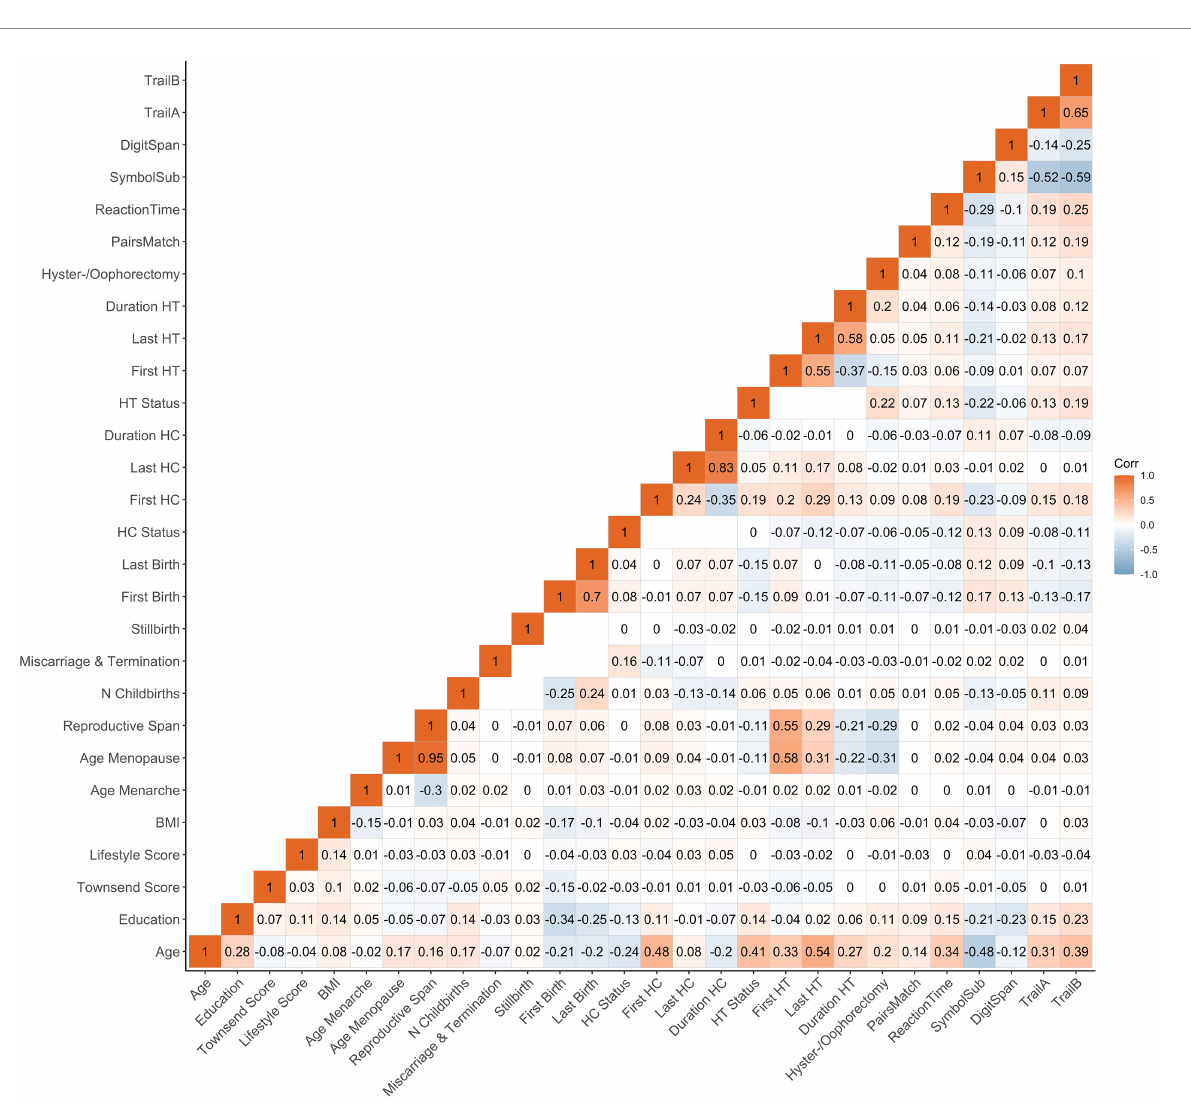
FIGURE 1 Correlations (Pearson’s r) between demographics, female-specific factors and cognitive test scores. Correlation between each pair of variables is computed using all complete pairs of observations on those variables. Empty fields indicate no complete pairs for that pair of variables. BMI, body mass index; HT, hormone therapy; HC, hormonal contraceptive; N, number; First Birth, age at first live birth (years); Last Birth, age at last live birth (years); First HC, age at first HC use (years); Last HC, age at last HC use (years); First HT, age at first HT use (years); Last HT, age at last HT use